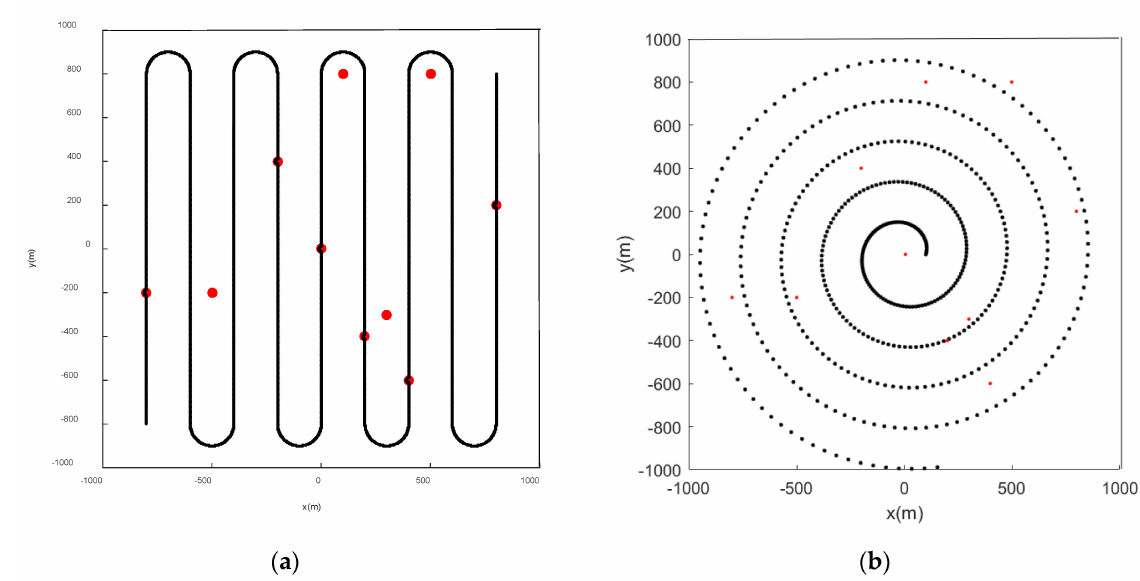
Figure 4. Initial path planning: ( a ) Serpentine curve; ( b ) Spiral curve.